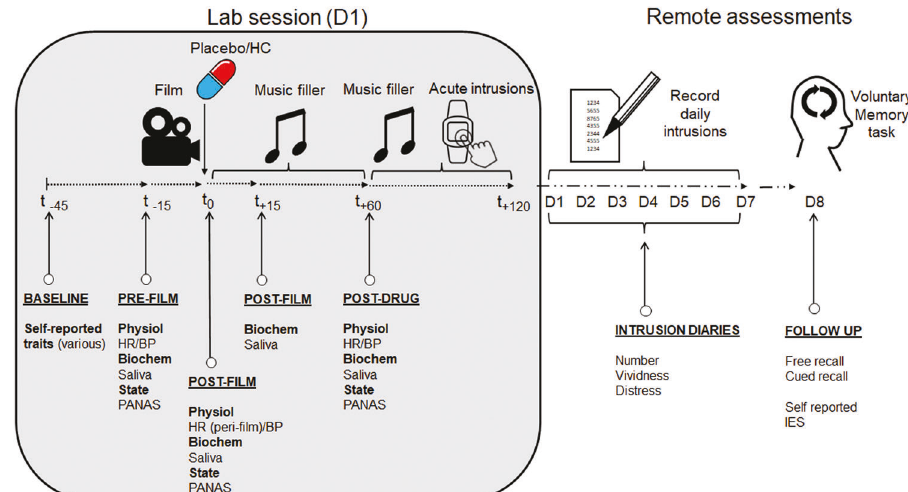
Fig. 1 Timeline of relevant experimental procedures. The timeline of the lab session on day 1 (D1) is outlined in the shaded grey box, which indicates the relative timing of in-session procedures ( fi lm viewing, drug administration, fi ller task, button presses in response to acute intrusions) and repeated measures, within-session physiological (HR heart rate, BP blood pressure), subjective “ state ” (PANAS: Positive and Negative Affect Schedule) and hormonal variables ( “ Biochem ” /Saliva). After drug administration, there was a 60 min drug absorption period and initial music fi ller task ( t 0 to t + 60 ). The fi nal 60 min of the lab session ( t + 60 to t + 120 ) was a second music fi ller, although participants additionally recorded spontaneous fi lm-related intrusions in this ‘ acute ’ drug phase using a wrist-worn monitoring device. Depicted to the right of the lab session box, are the remotely recorded memory procedures, starting at the end of D1 and continuing for the next six days (D2 – D7). On D8, participants did not complete a memory diary, but instead completed free and cued recall tasks and the Impact of Events Scale (IES). D2-D8 procedures were conducted